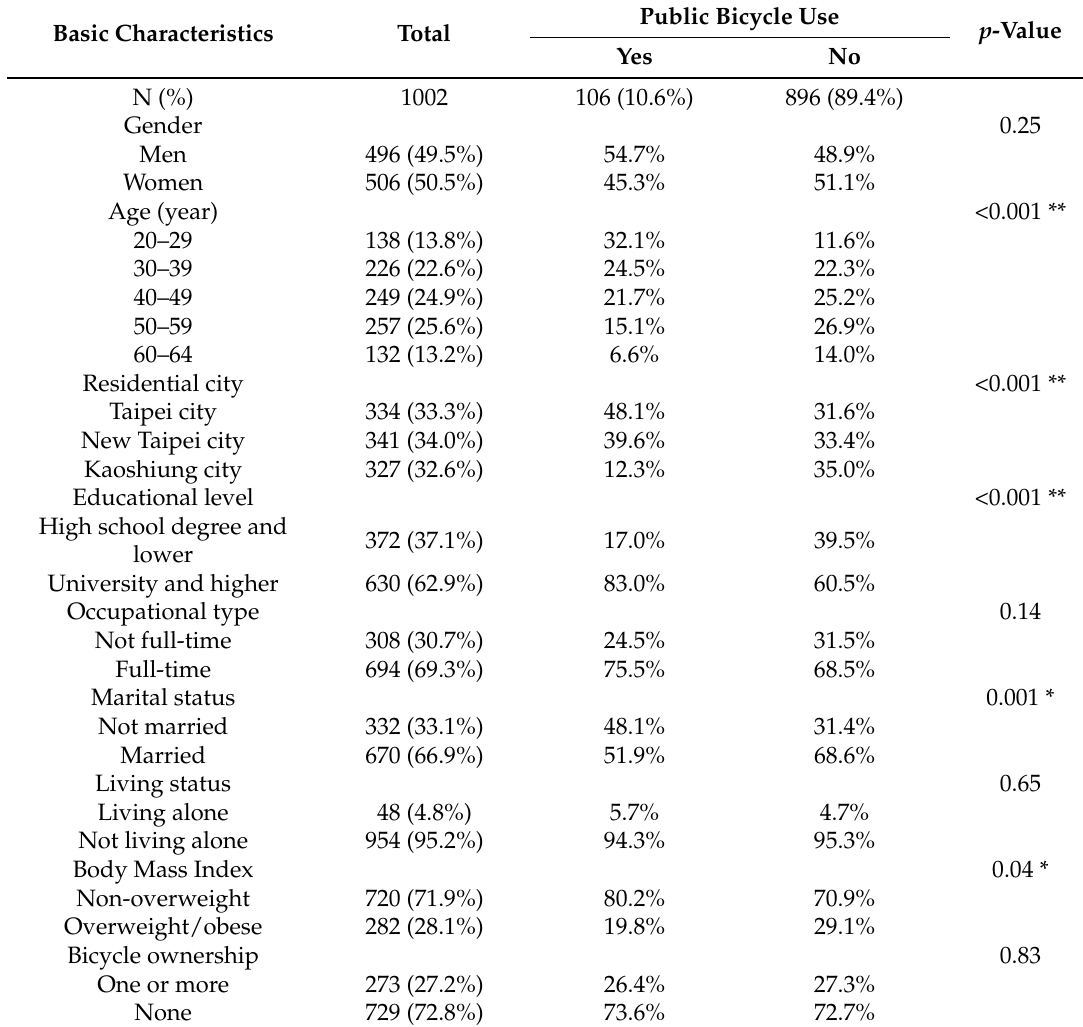
Table 1. Basic characteristics of respondents ( n =